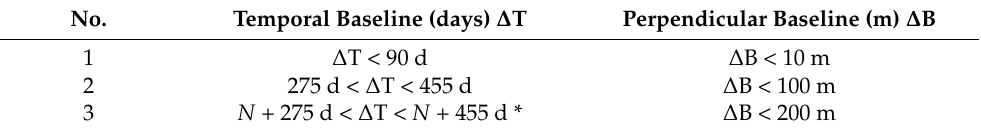
Table 1. Temporal and spatial baseline thresholds.